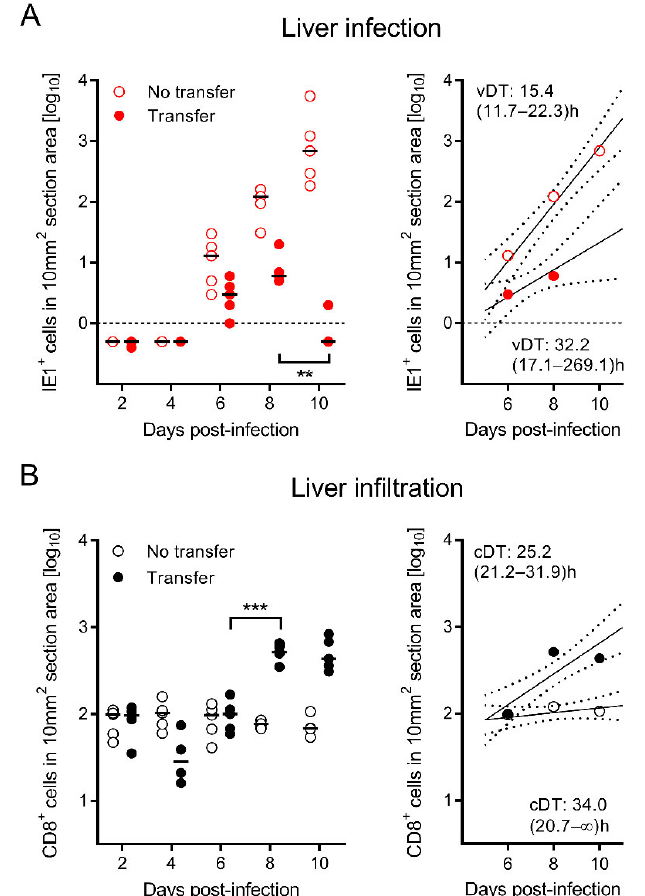
Figure 3. CD8-AT inhibits exponential virus spread in liver tissue reflected by a prolonged viral doubling time (vDT) of the number of infected liver cells, corresponding to enhanced tissue infiltration by CD8 T cells indicated by a shorter cellular doubling time (cDT). Data refer to the same experiment as shown in Figure 2. 2C-IHC was performed to quantitate infected liver cells (mostly hepatocytes) by red staining of the intranuclear viral protein IE1 ( A ) and tissue-infiltrating CD8 T cells by black staining of the CD8a molecule ( B ). Red- or black-rimmed empty circles—no AT. Red or black filled circles—AT. For further details, see the legend of Figure 2. The dashed lines in ( A ) represent the detection limit of the IE1-specific IHC. For comparisons of most interest, significance levels were determined. For the comparison of groups that include data below the detection limit, as is the case in ( A ), the distribution-free Wilcoxon–Mann–Whitney test was applied. Otherwise, the Student’s t -test with Welch’s correction of unequal variance was performed for log-transformed data in ( B ). Significant with p < 0.01 (**) or p < 0.001